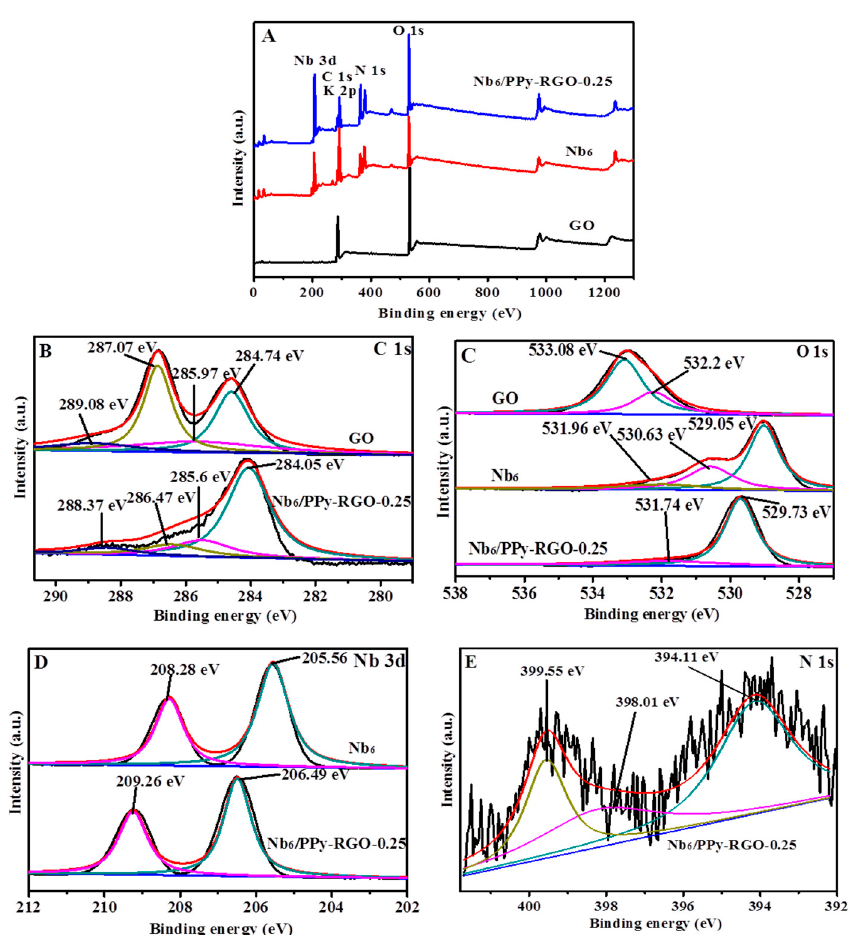
Figure 4. X-ray photoelectron spectroscopy (XPS) of GO, Nb 6 , and Nb 6 /PPy-RGO-0.25, ( A ) survey; ( B ) C 1s; ( C ) O 1s; ( D ) Nb 3d; ( E ) N 1s.